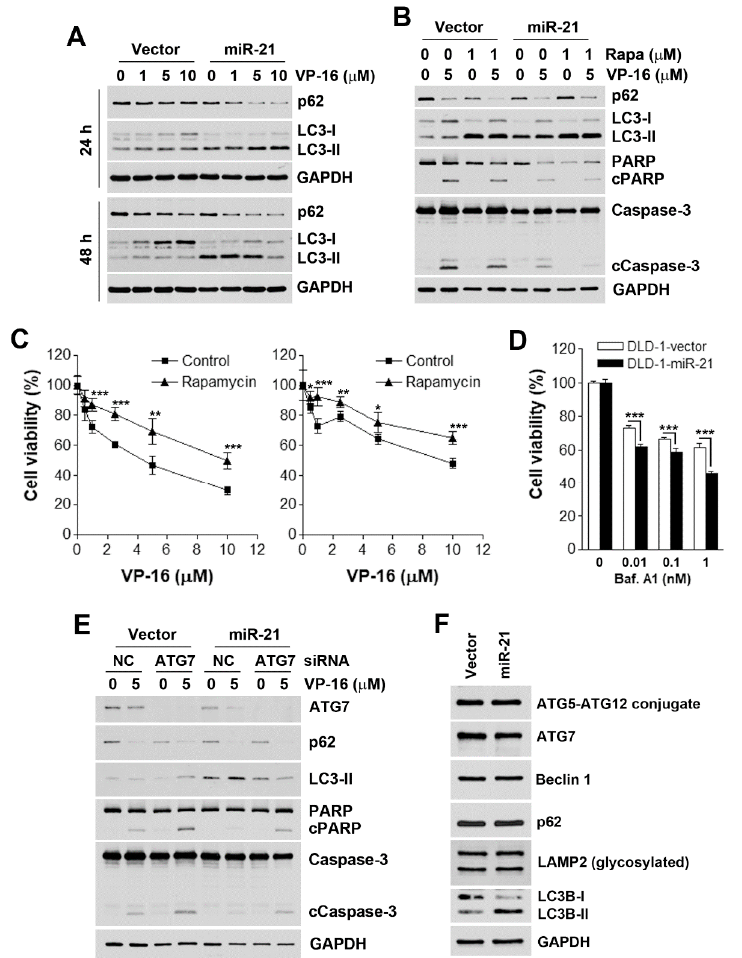
Figure 3. E ff ect of autophagy on miR-21-induced drug resistance. ( A ) DLD-1-vector and DLD-1-miR-21 cells were treated with various doses of VP-16 for 24 and 48 h. Whole-cell lysates were prepared and subjected to a Western blot analysis. ( B ) DLD-1-vector and DLD-1-miR-21 cells were treated with various doses of VP-16 with or without 1 μ M rapamycin (Rapa) for 48 h. Whole-cell lysates were prepared and subjected to a Western blot analysis. ( C ) DLD-1-vector and DLD-1-miR-21 cells were treated with various doses of VP-16 with or without 0.5 μ M rapamycin for 72 h. Cell viability was examined by an MTT assay. p < 0.05 (*), p < 0.01 (**), or p < 0.001 (***) indicates significant differences between rapamycin-treated and control cells. ( D ) DLD-1-vector and DLD-1-miR-21 cells were treated with various doses of bafilomycin A1 for 72 h. Cell viability was analyzed by an MTT assay. p < 0.001 (***) indicates significant di ff erences between DLD-1-vector and DLD-1-miR-21 cells. ( E ) DLD-1-vector and DLD-1-miR-21 cells were transfected with ATG7 or non-targeting siRNAs for 48 h before exposure to 5 µ M VP-16 for 48 h. Then, whole-cell lysates were prepared and subjected to a Western blot analysis. ( F ) The untreated whole-cell lysates from DLD-1-vector and DLD-1-miR-21 cells were analyzed by Western blot